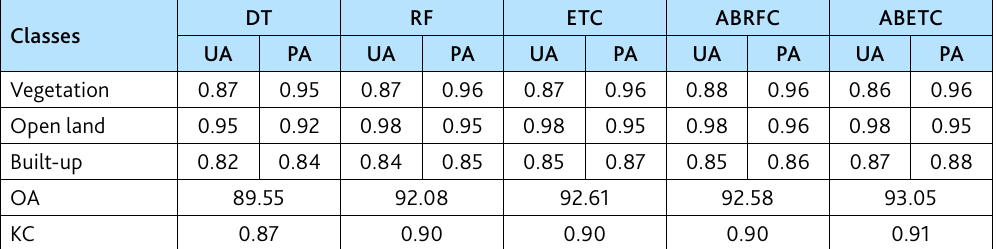
Table 3. Accuracy Statistics comparison for DT, RF, ETC, ABRFC, and ABETC Classifiers for Ahmedabad